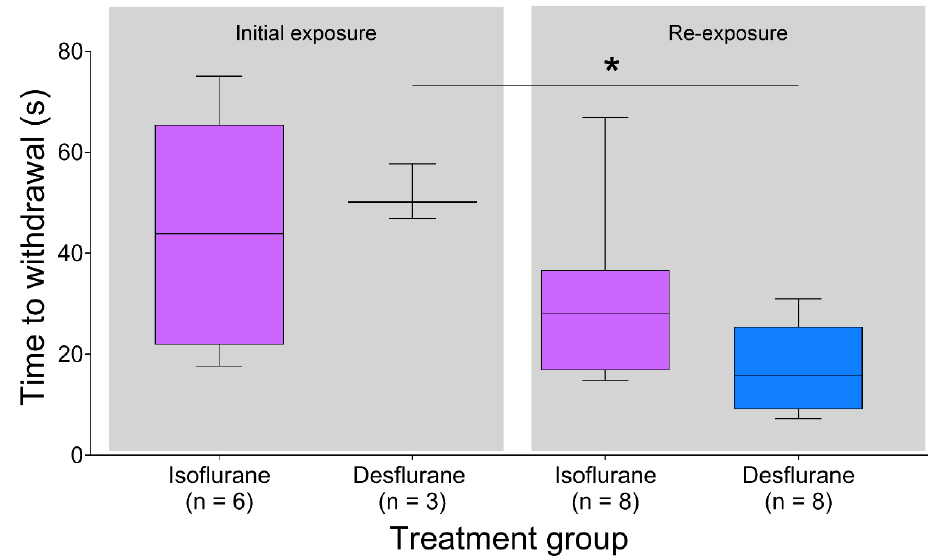
Figure 3. Time to withdrawal was similar for desflurane and isoflurane during both initial and re-exposure. Times to withdrawal between initial and re-exposure was not significant for isoflurane, but was significant for desflurane ( p < 0.05). Data are presented as median (middle line in box), IQR (box limits) and 10–90 percentile (whiskers). * p < 0.05.